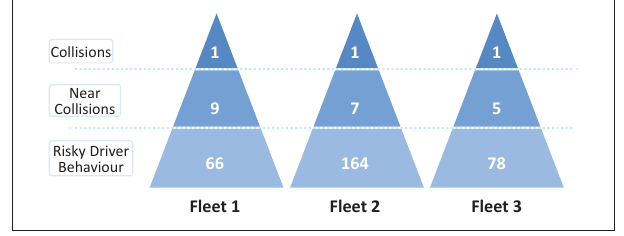
FIGURE 6: Fleet 3 – Average number of incidents per vehicle (couriers).